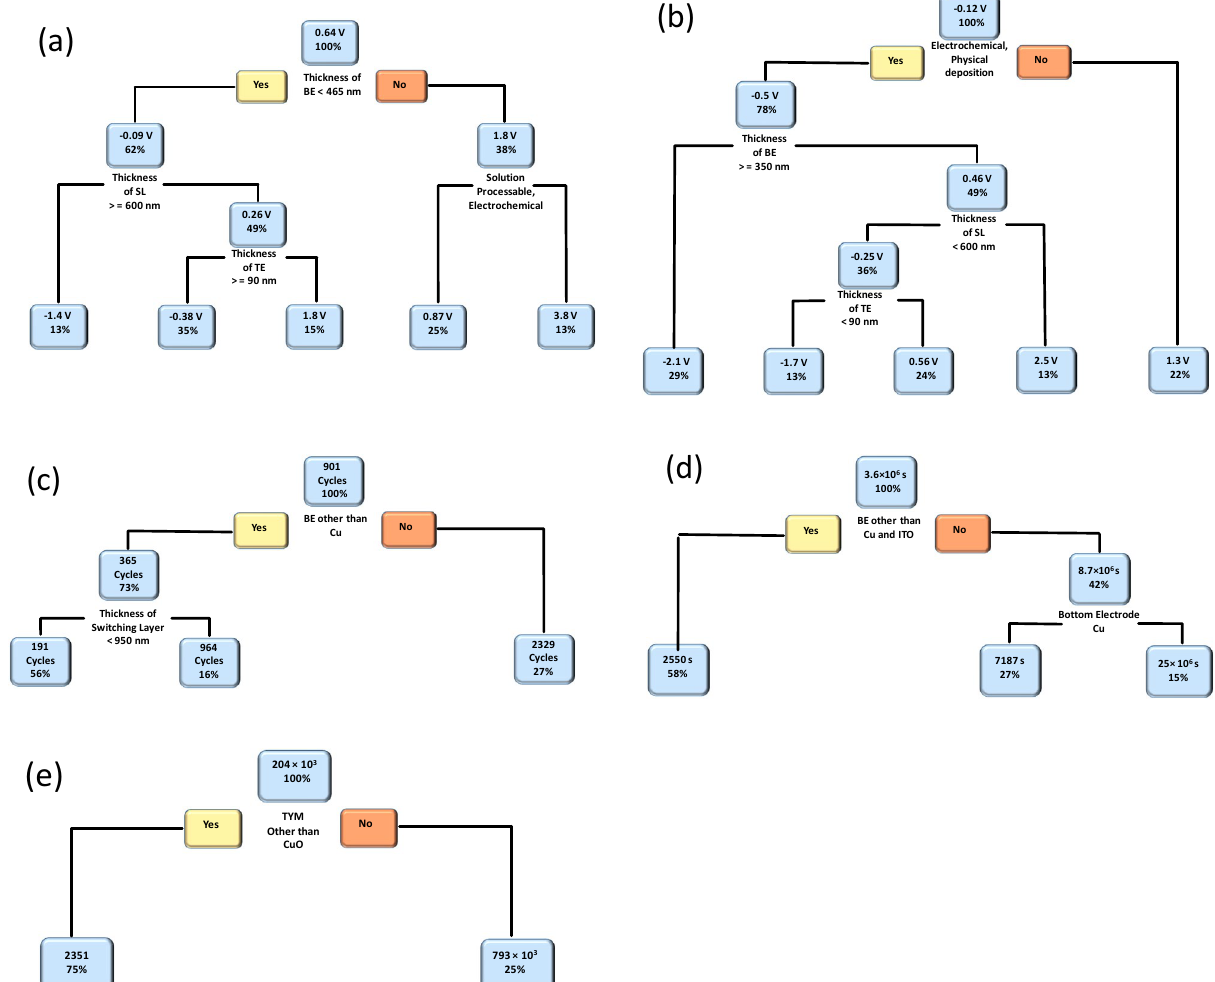
Figure 2. CART algorithm-based ML predictive model for copper oxide-based devices. The performance parameters such as ( a ) V SET (V), ( b ) V RESET (V), ( c ) endurance (cycles), ( d ) retention (s), and ( e ) memory window (unitless) are modeled using the CART-based ML